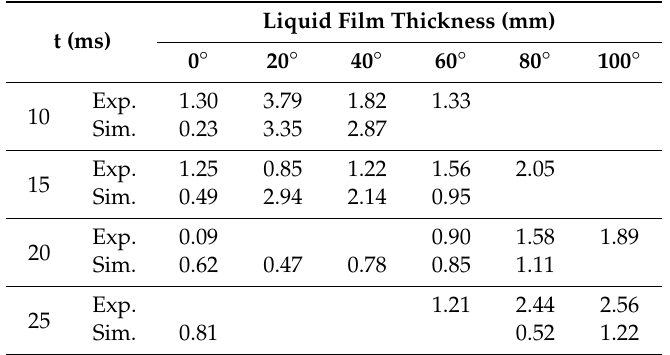
Table 3. Thickness of liquid film on particle surface of di ff erent positions.